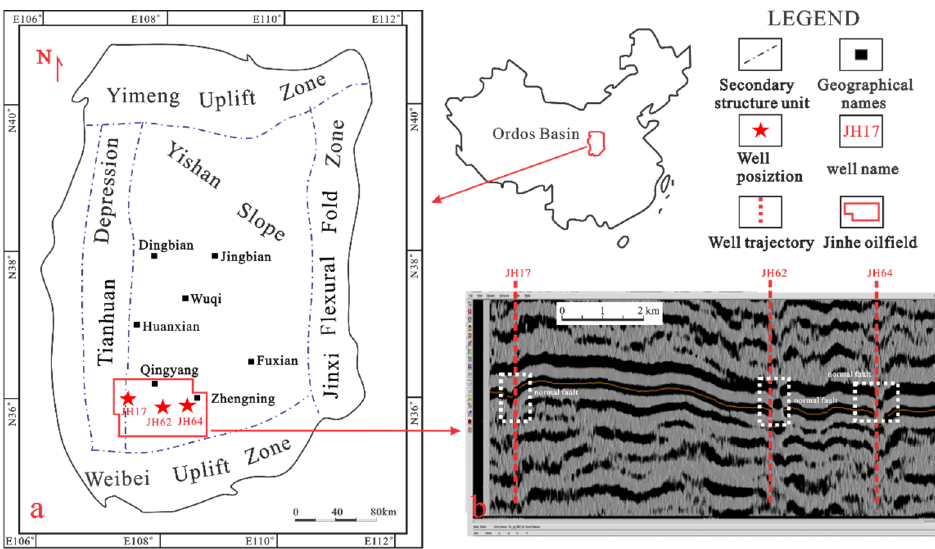
Figure 3. Prototype of physical simulation of geological structural deformation experiment. ( a ) The geographical position; ( b ) The seismic interpretation section of Jinhe Oilfield.